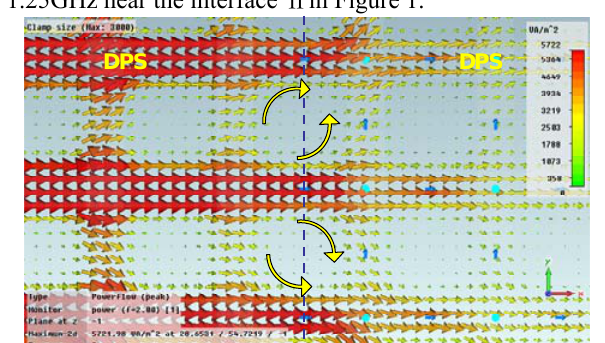
(c) Power flow in 2.00GHz near the interface in the Ⅰ black dashed rectangle region in Figure 1.